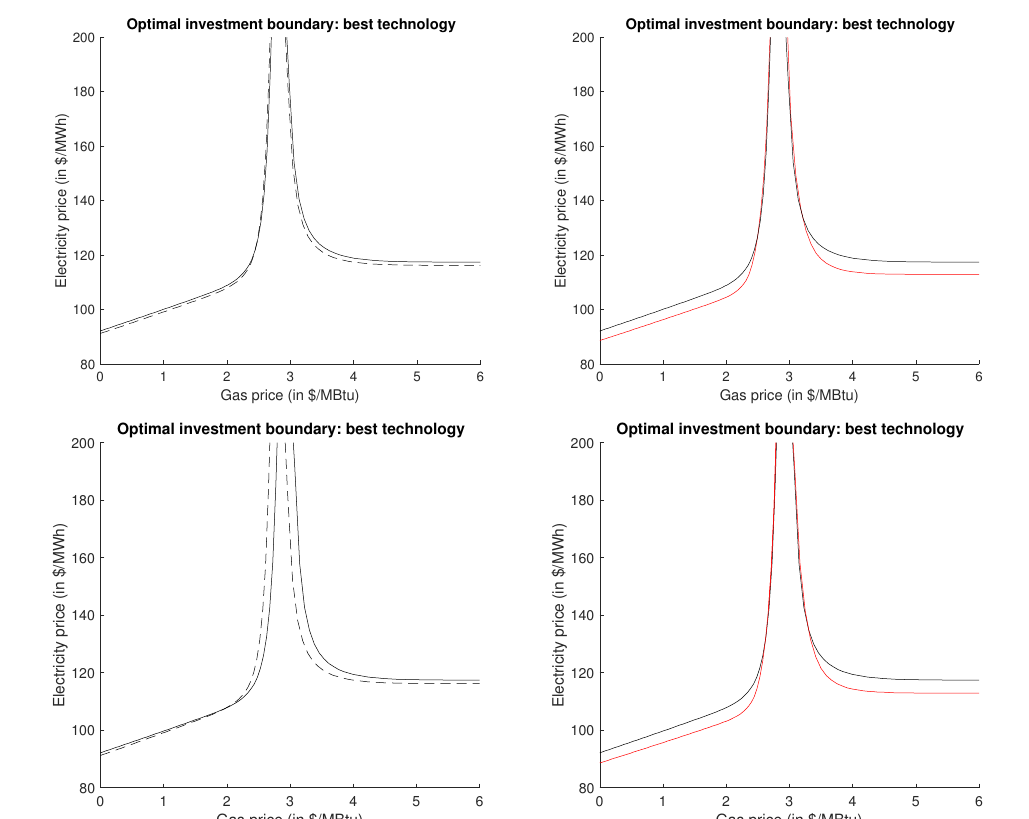
Figure 5. This figure displays the investment boundary for the best of two technologies in case of low sensitivity C = 0 of the gas price (upper panels) and of high sensitivity C = 2.5 (lower panels). Left panels: black solid line corresponds to the pandemic case at t = 0, black dashed line to the no-pandemic case at t = 0. Right panels: black solid line corresponds to the pandemic case at t = 0, red solid line to the pandemic case at t = 0.3. Parameter values are given in Table 1; the investment horizon is T = 1 year.